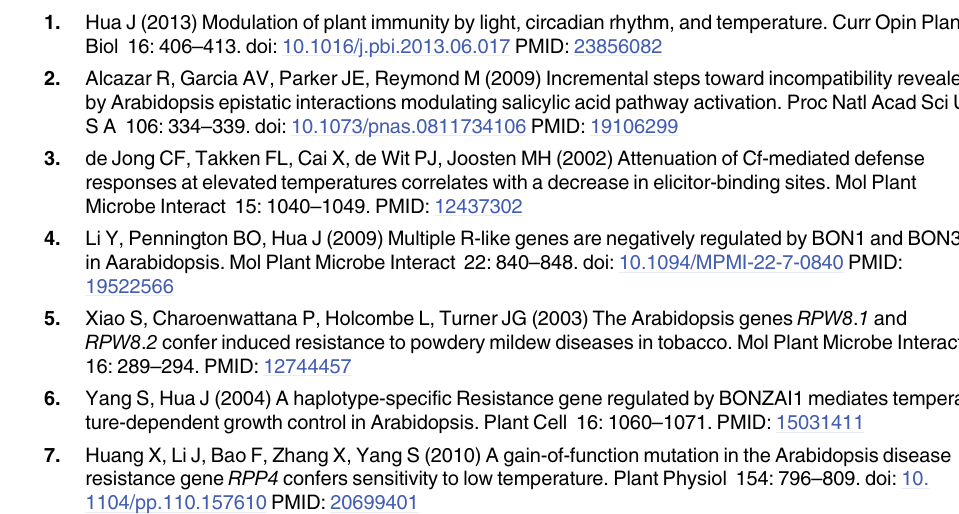
S1 Table. Gene-specific primers used in this